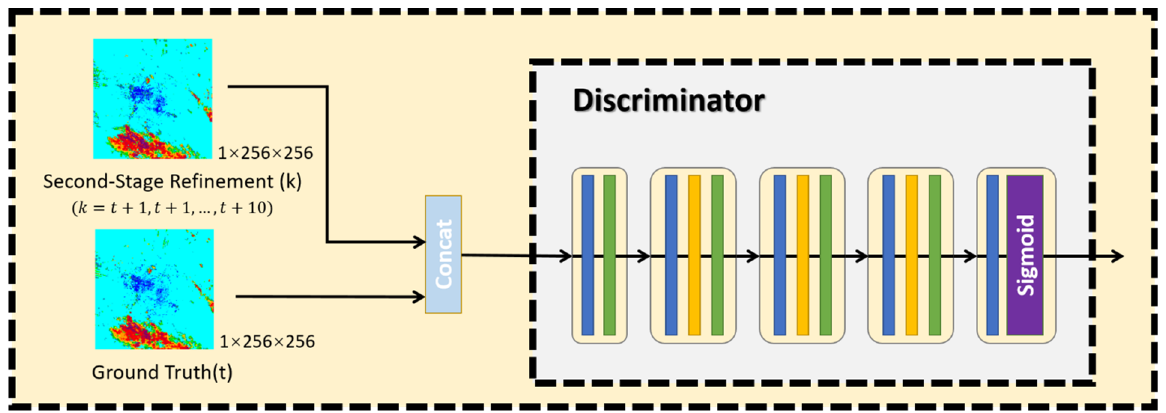
Figure 6. Structure of the discriminator. Table 5. The structure of the discriminator used in UA-GAN (Stage